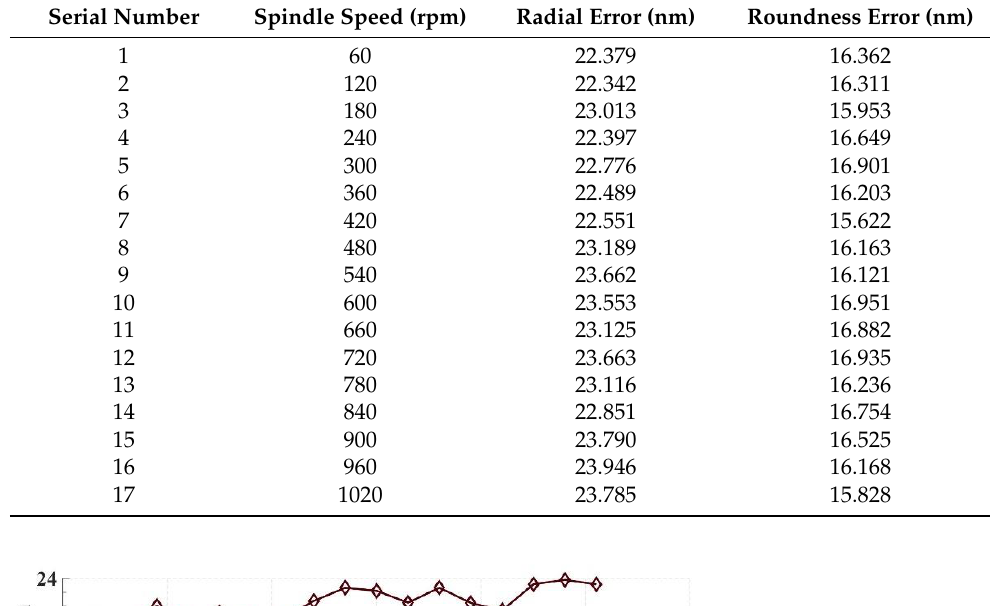
Table 1. Measurement results of radial error by in situ measurement and evaluation system.